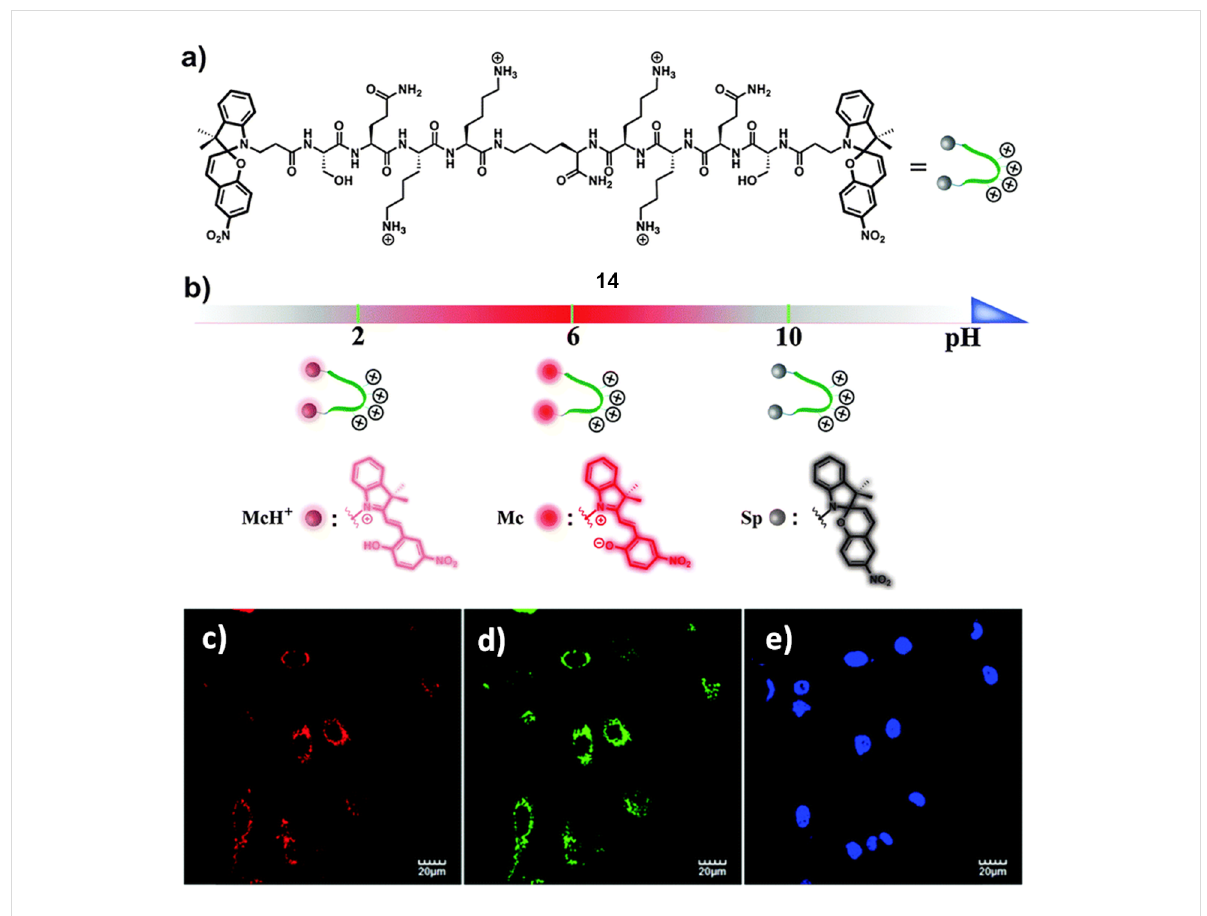
Figure 11: a) Molecular structure of peptide 14 ; b) the coordinate represents the states of sensor at different pH values, purple sphere: protonated merocyanine (McH + ), red sphere: normal merocyanine (Mc), and gray sphere: spiropyran at a ring-closed state (Sp); colocalization experiments using peptide 14 , LysoTracker Green DND-26 (LTG) and Hoechst 33258 in A549 cells. Cells were stained with c) 10 µM peptide 14 (channel 1: excitation: 515 nm, emission collected: 600–650 nm), d) 0.1 µM LTG (channel 2: excitation: 488 nm, emission collected: 500–550 nm) and e) 10 µg/mL Hoechst 33258 (channel 3: excitation: 405 nm, emission collected: 420–470 nm). Reproduced from [64], “A switchable peptide sensor for real-time lysosomal tracking”, © 2014 Chen et al., licensed under a Creative Commons Attribution 3.0 Unported Licence,